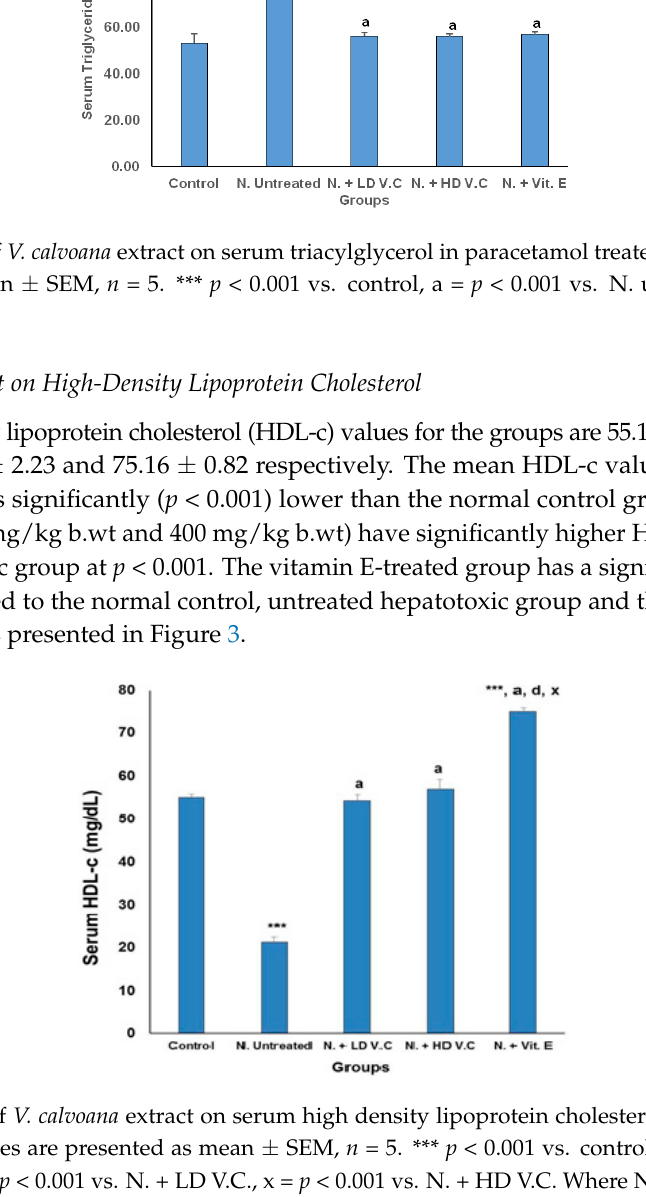
Figure 3. Effect of V. calvoana extract on serum high density lipoprotein cholesterol in paracetamol treated rats. Values are presented as mean ± SEM, n = 5. *** p <0.001 vs. control, a = p <0.001 vs N. untreated, d = p <0.001 vs N. + LD V.C., x = p < 0.001 vs N. + HD V.C. Where N = hepatotoxic.